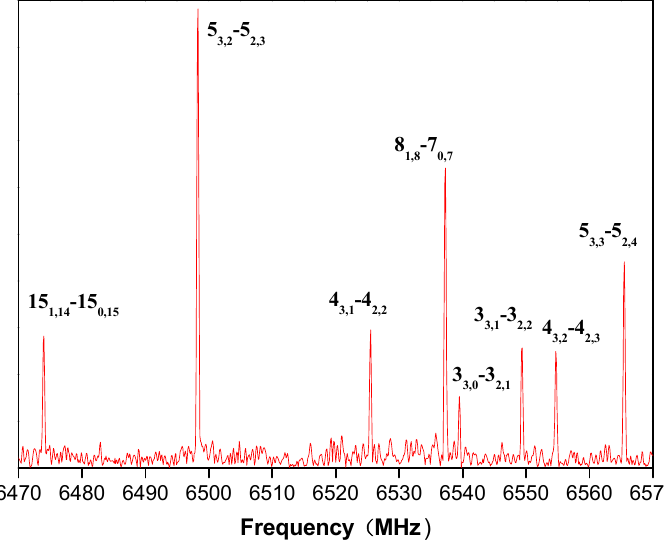
Figure 4. A partial experimental spectrum of benzophenone with 8 assigned rotational transitions.